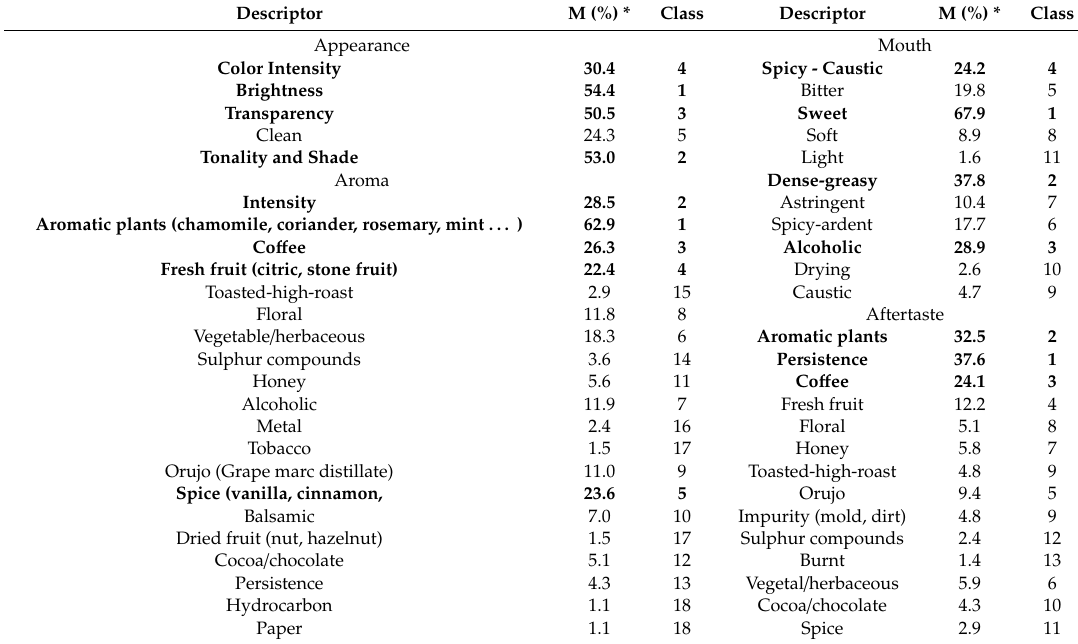
Table 1. Classification of the sensory descriptors by their geometric